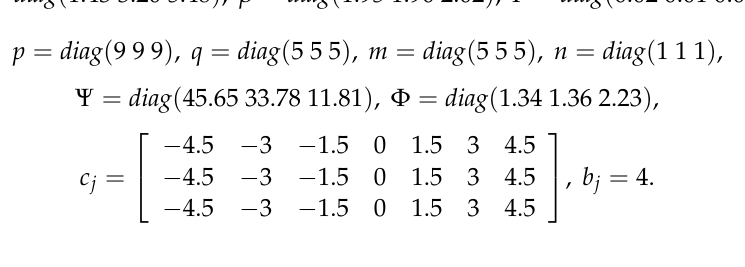
Table 1. Physical parameters of the three-axis stabilized